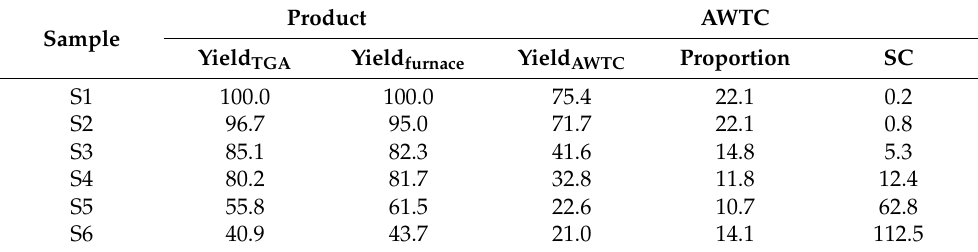
Figure 1. Mass loss performance of activation treatment process in TGA. Table 1. The yields and specific capacitances at six